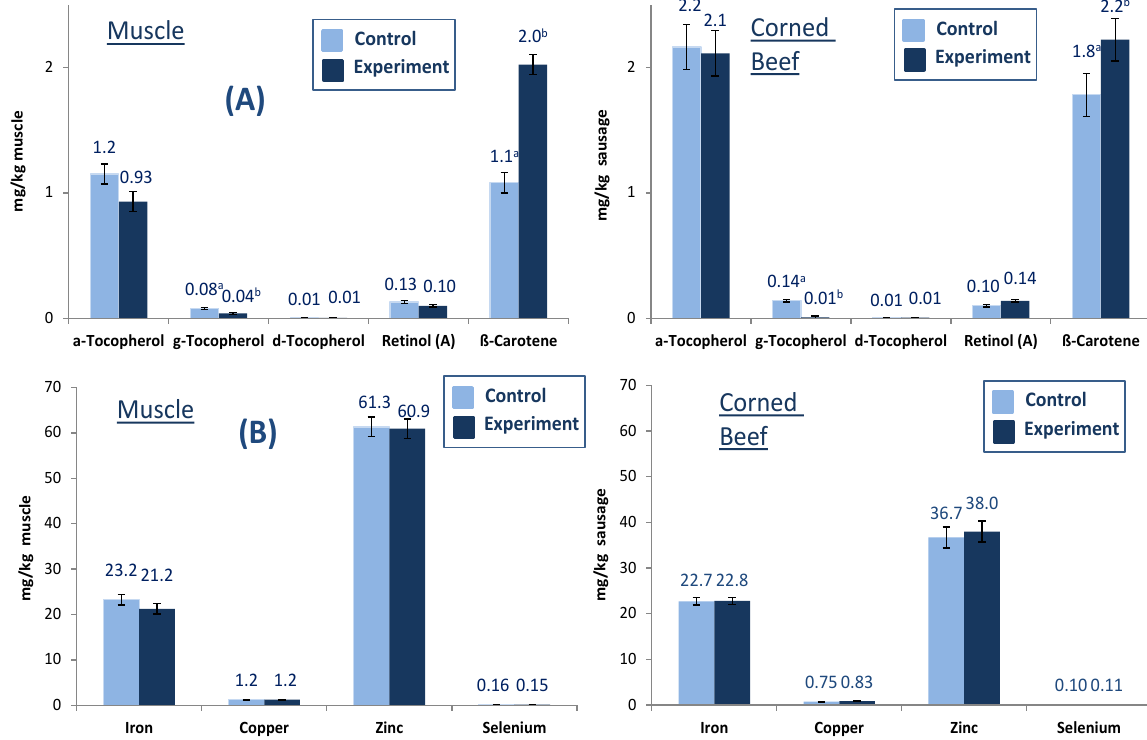
Figure 1. Fat soluble vitamin ( A ) and trace metal ( B ) concentrations (mg/kg) in fresh muscle and beef product (GCB) from German Holstein bulls fed different diets (different letters (a, b) denote significant effect of